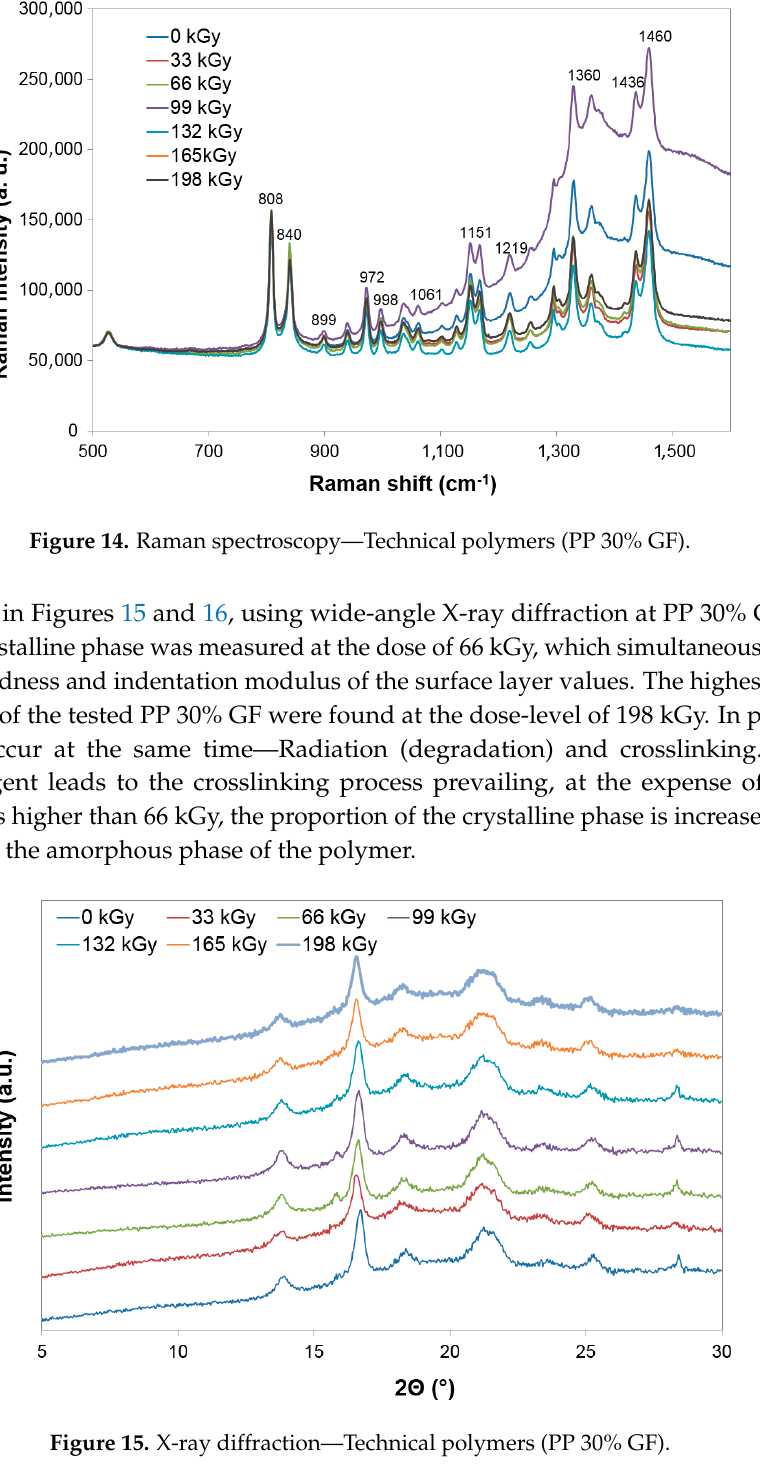
Figure 15. X-ray diffraction—Technical polymers (PP 30% GF).